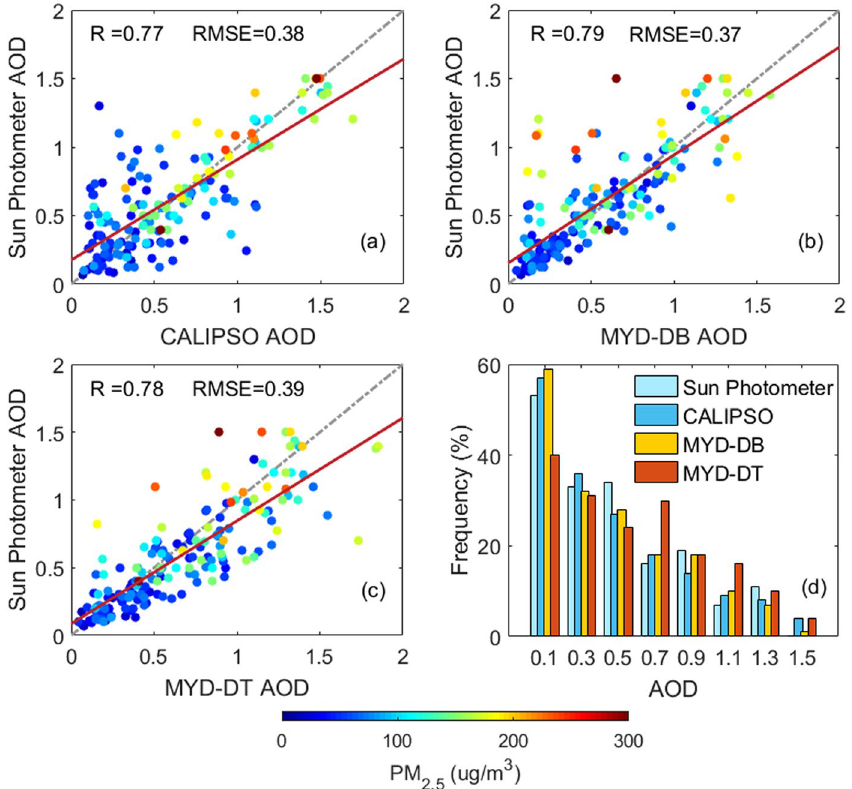
Figure 1. Scatter plots of the AODs derived from CALIPSO, MODIS, and sun photometer with change of PM2.5 from November 2013 to December 2017. ( a ) CALIPSO vs. sun photometer; ( b ) MODIS-DB vs. sun photometer; ( c ) MODIS-DT vs. sun photometer; ( d ) frequency distribution of AODs. Color bars represent the mass concentration of